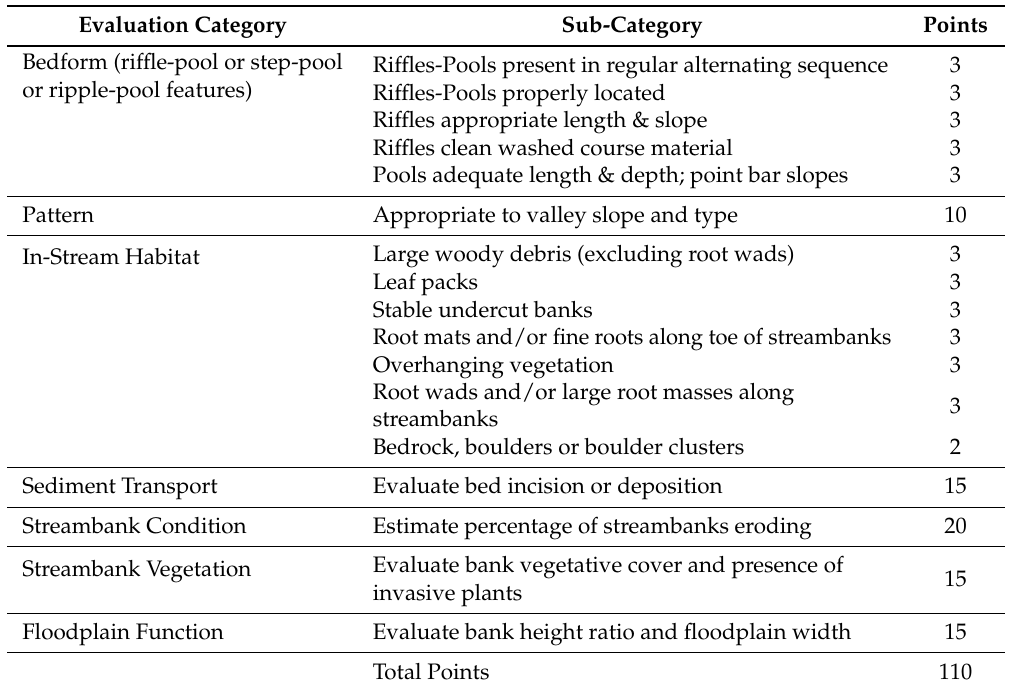
Table 2. Stream Performance Assessment (SPA) categories and point